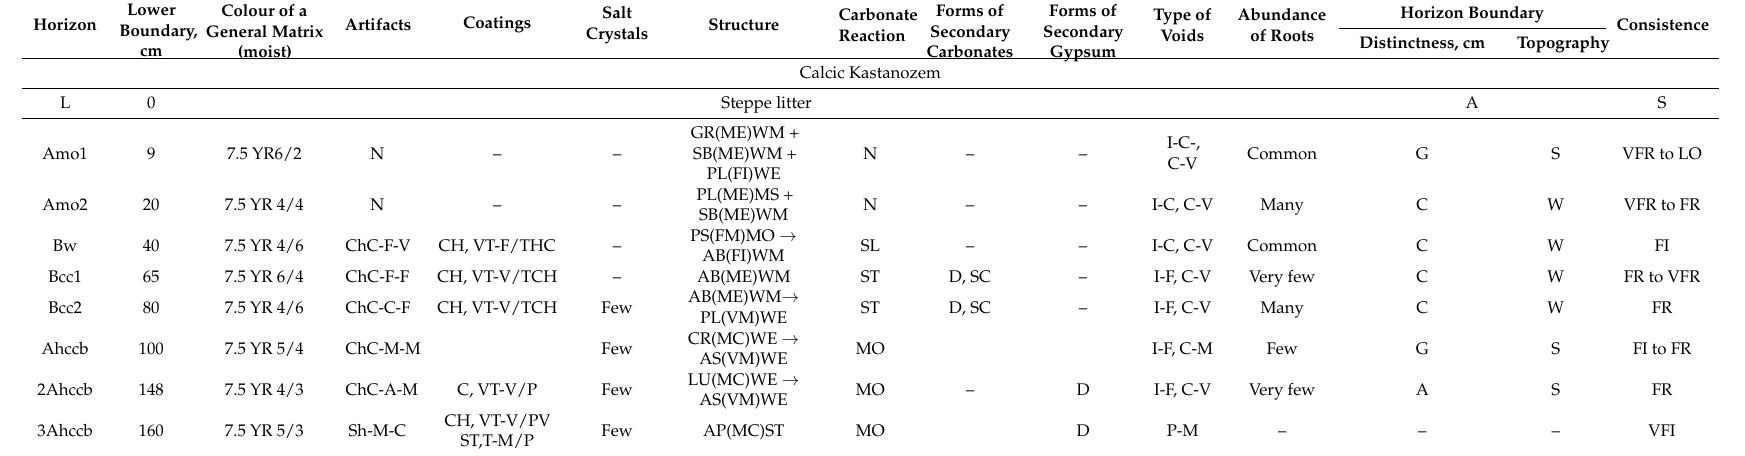
Table 1. Field morphology of the studied soil